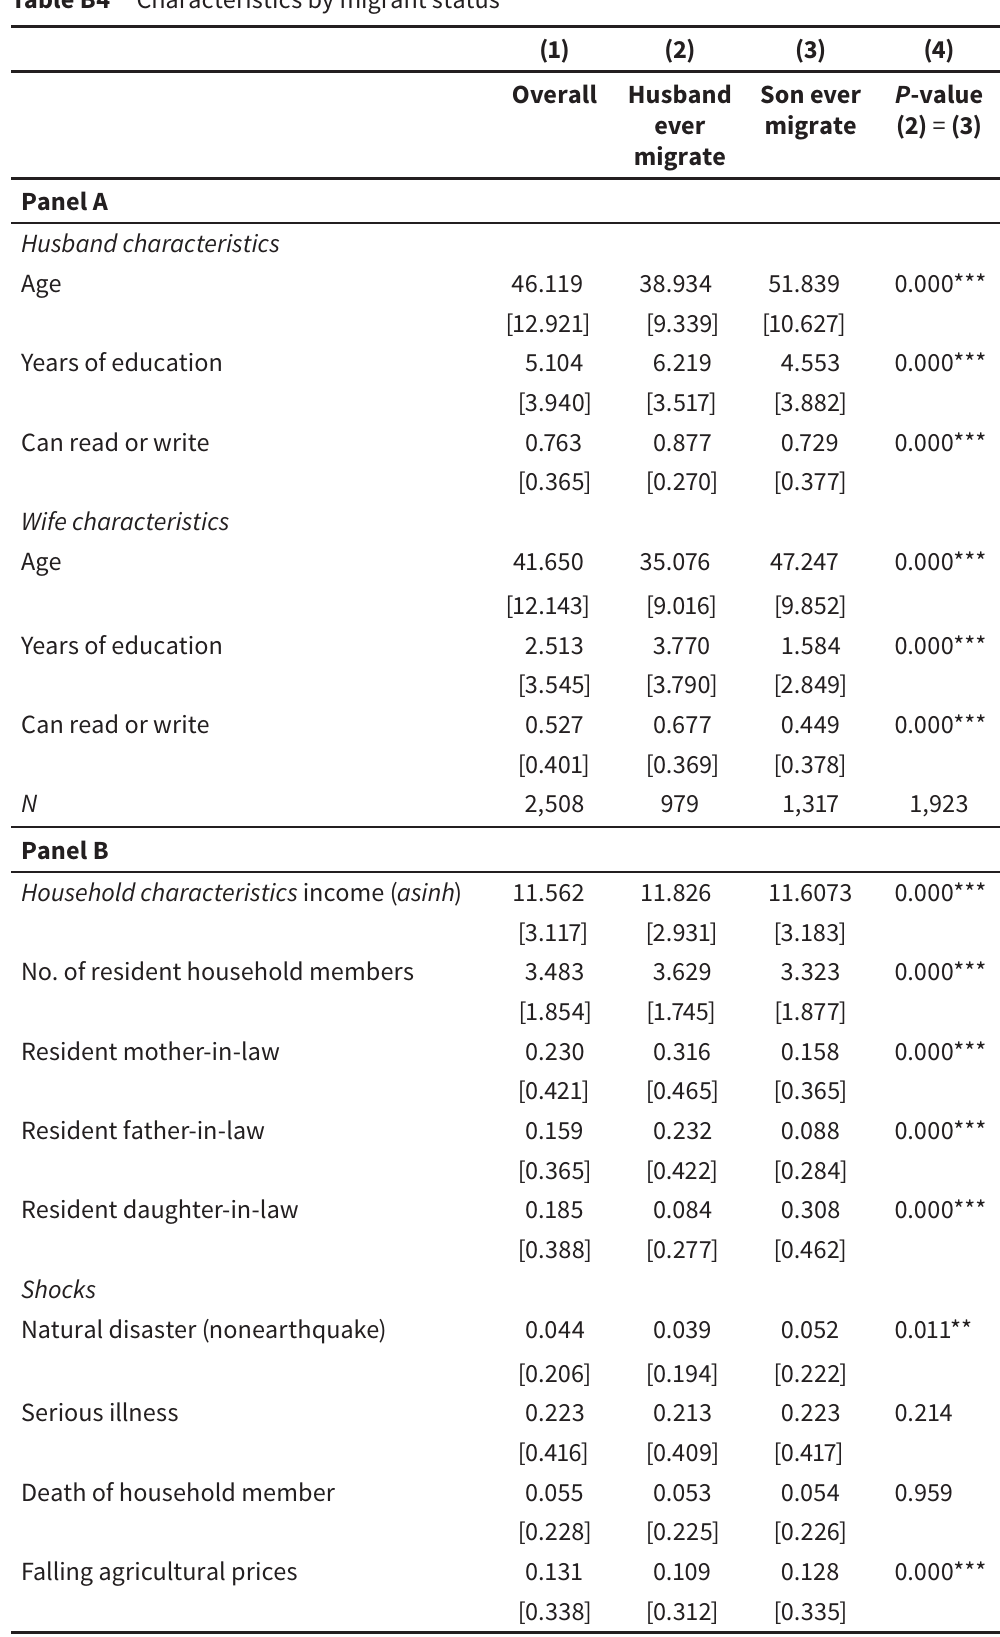
Characteristics by migrant